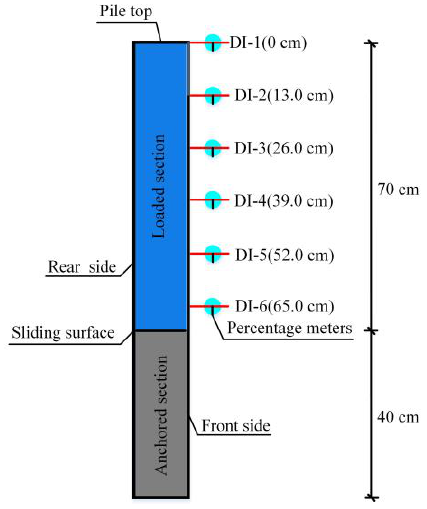
Figure 9. Arrangement of percentage meters.